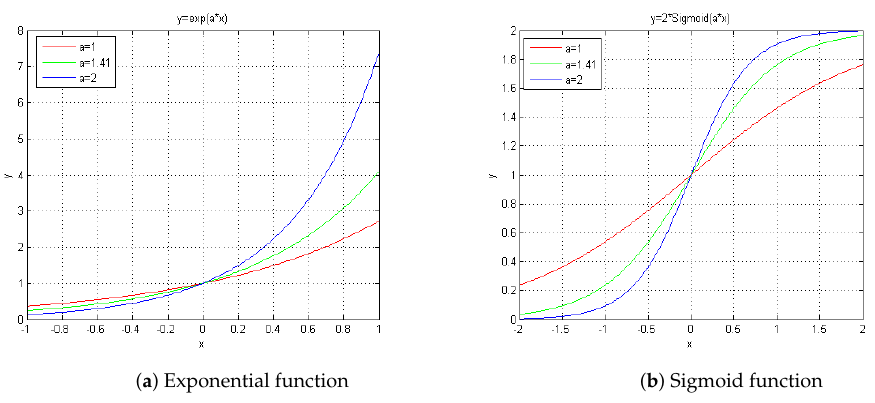
Figure 1. Comparison between exponential function and Sigmoid function.